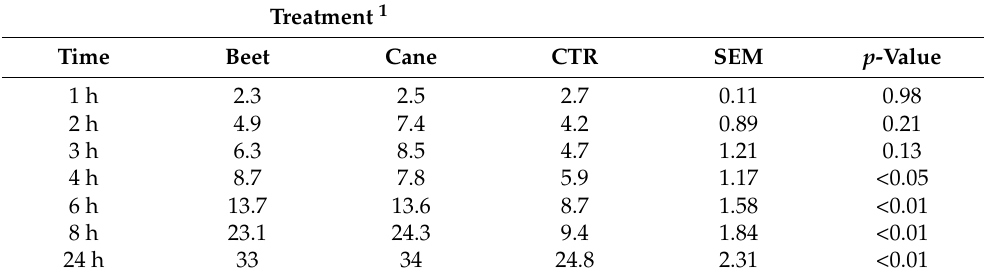
Table 2. Averaged total VFAs produced during in vitro incubations, expressed in mmol/L. Treatment 1 Time